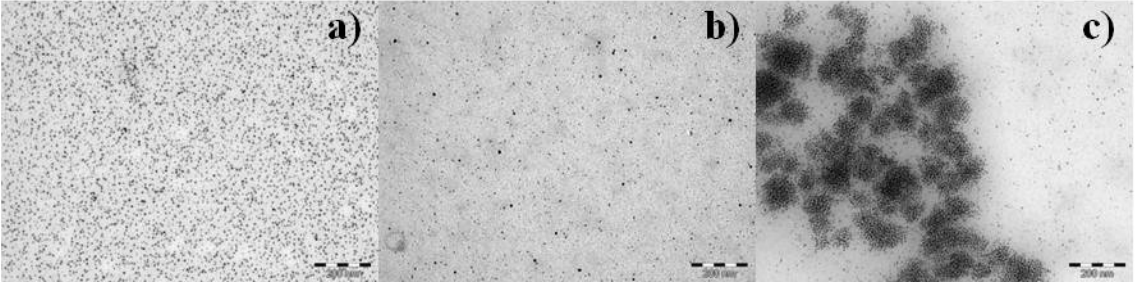
Figure 2. Co nanoparticles obtained with P41 after 3 h at 120 °C for ( a ) HDA: Co = 1 (1.5 wt% Co) ( b ) Boba:Co = 0.16 (10 wt% Co) ( c ) Boba:Co = 1 (1.5 wt% Co). Scale bars: 200 nm.